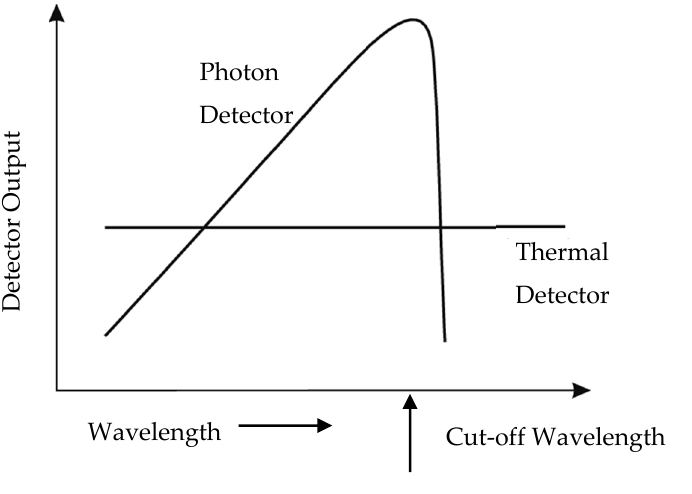
Figure 9. Wavelength response of detectors.